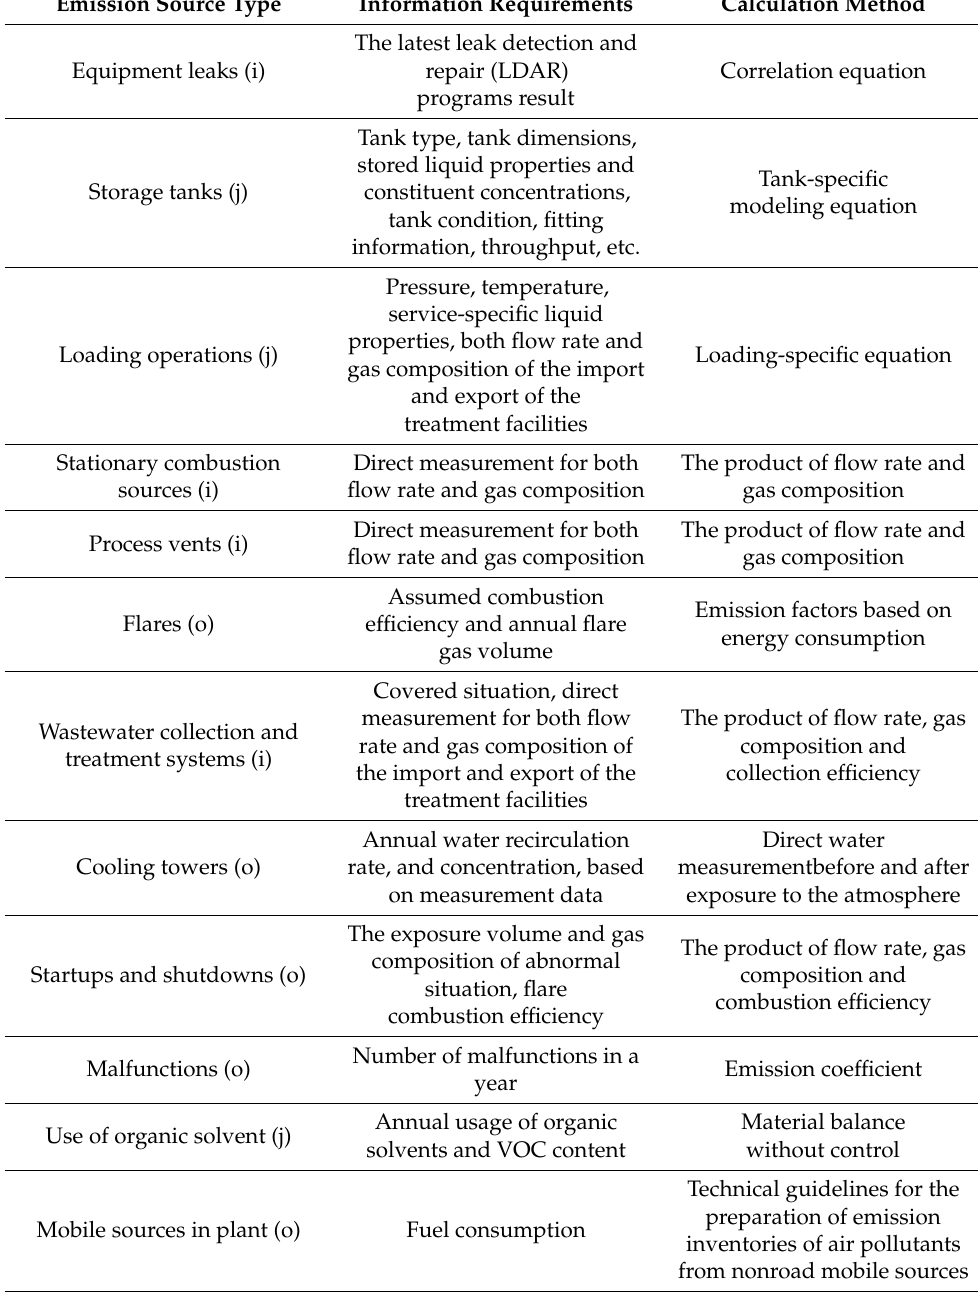
Table 3. Emission source classification and collected information for one PR enterprise